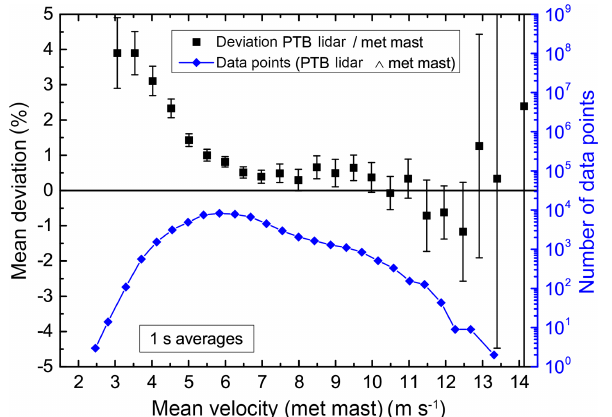
Figure 8. Comparison of PTB lidar with wind met mast for dis- turbed wind conditions (campaign